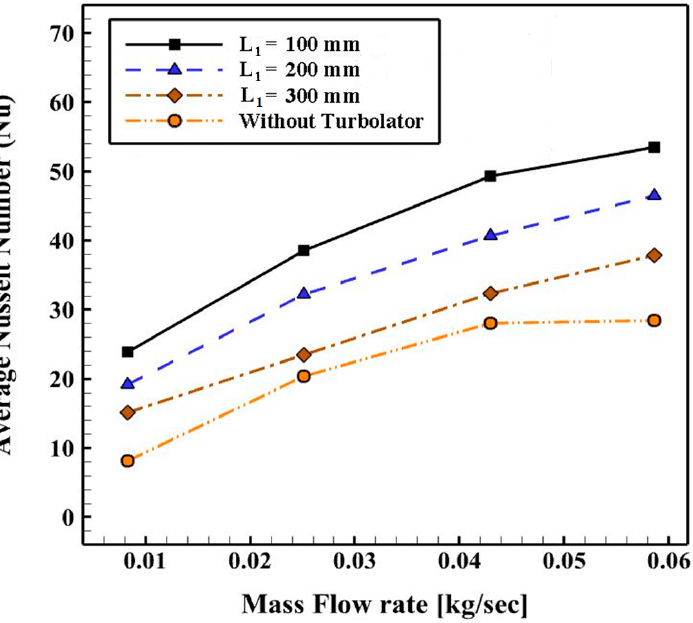
Figure 8. The deviations of average Nusselt number versus the mass flow rates for various cases (L 1 ) at n = 12, θ = 180 degrees, and S = 0.3 π mm.